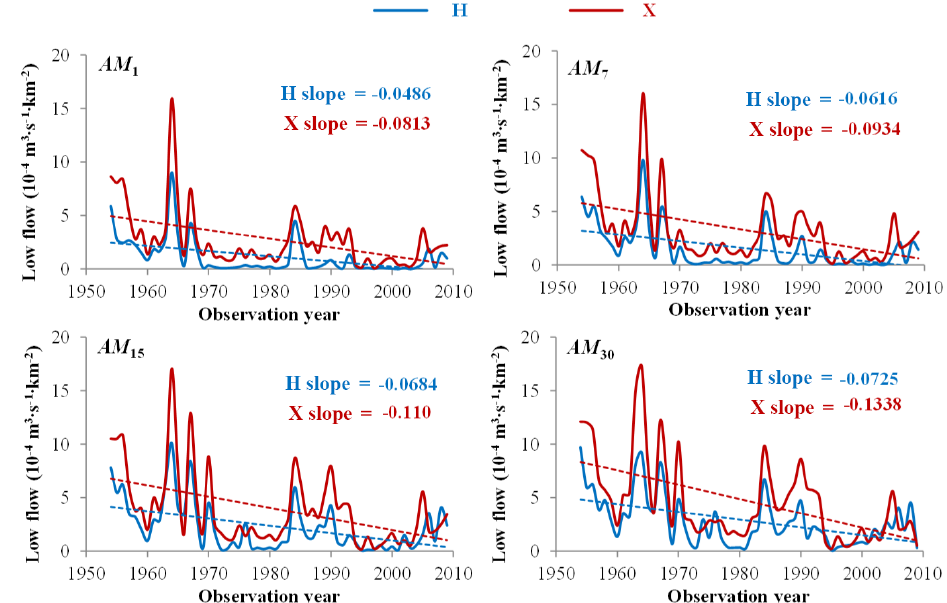
Figure 3. The annual minimum low flows and fitted trend lines in both Huaxian (H) and Xianyang (X) gauging